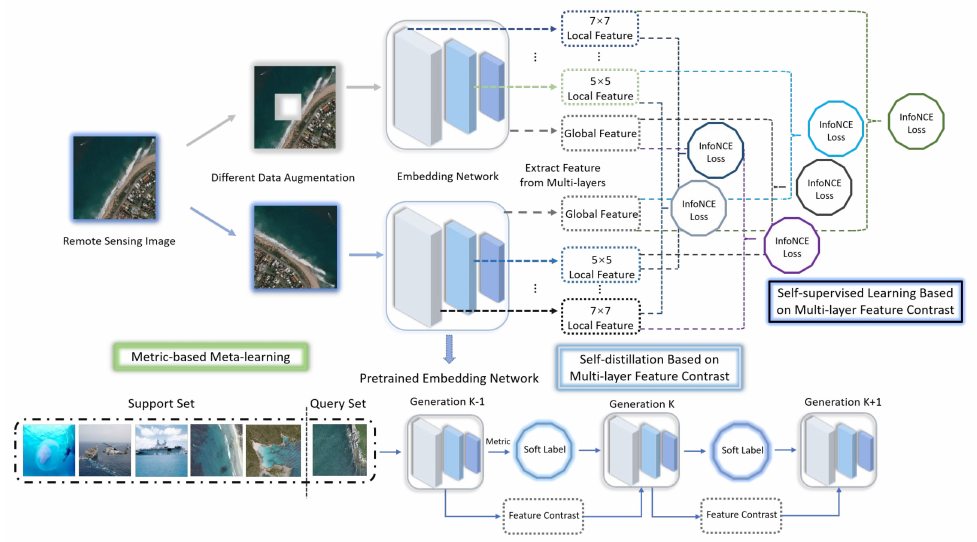
Figure 1. The overall architecture of the SSMR method that we propose. The first stage is the self-supervised learning stage, using multi-layer feature contrast. In this stage, a feature extractor is trained as the embedding network of the second stage meta-learning. During the second stage, few-shot learning takes place using meta-learning. In the third stage, the model obtained in the second stage is subject to self-distillation based on multi-layer feature